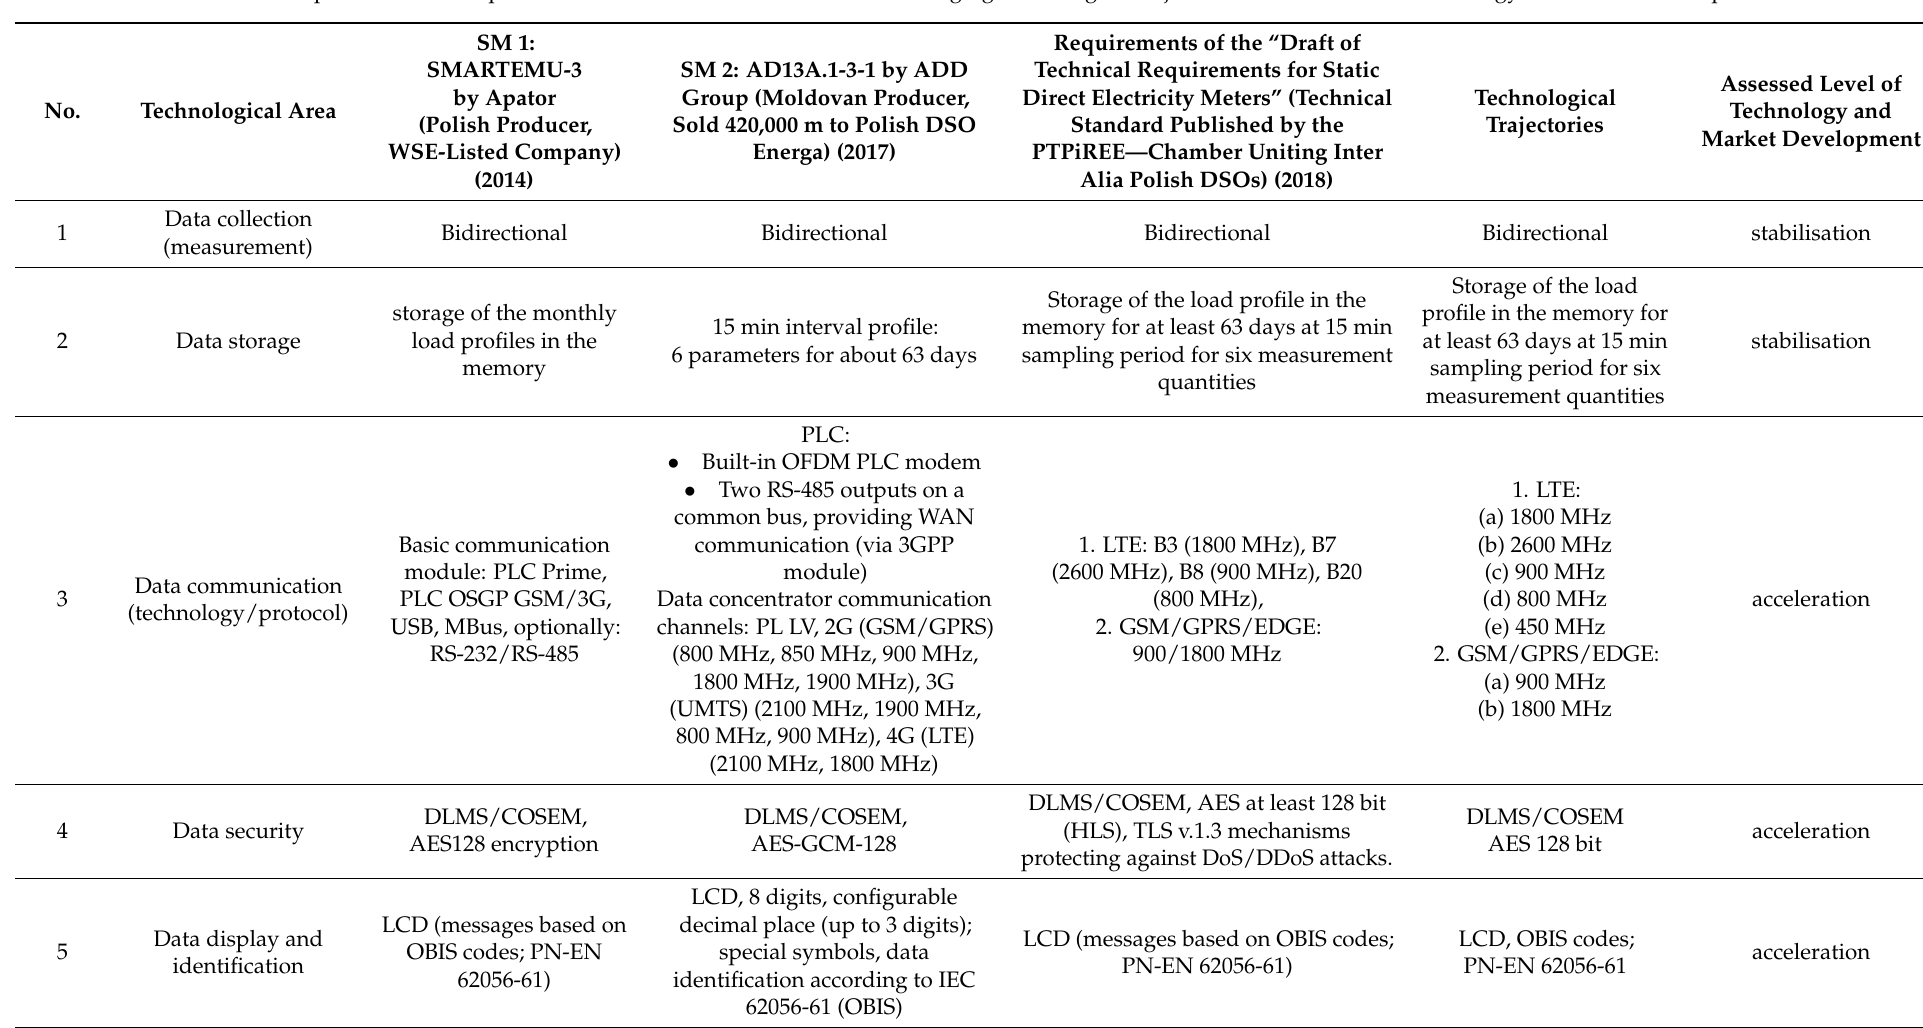
Table 2. Examples of technical specifications of SMs installed in Poland—emerging technological trajectories and the level of technology and market